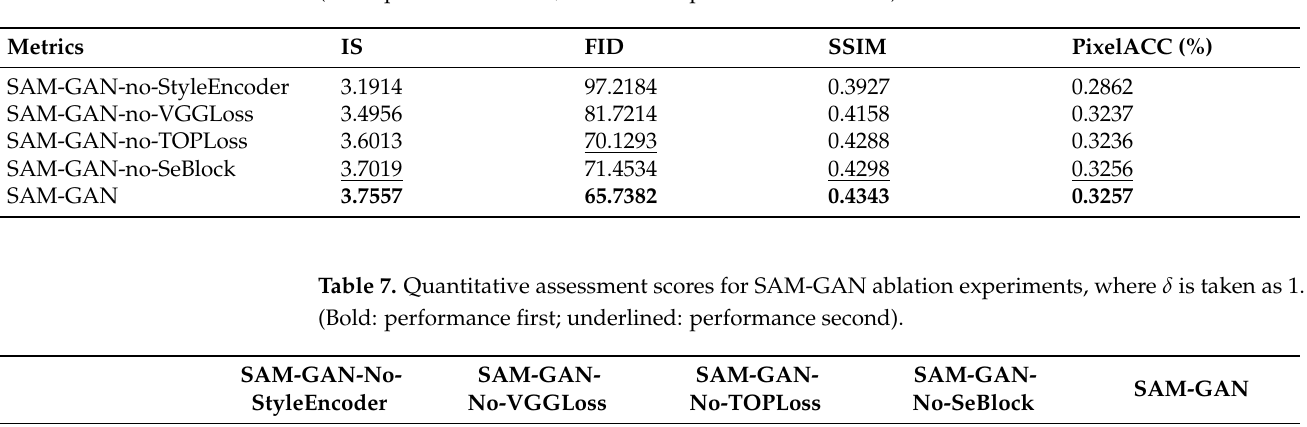
Table 6. Quantitative assessment scores for SAM-GAN ablation experiments, where δ is taken as 1. (Bold: performance first; underlined: performance second).